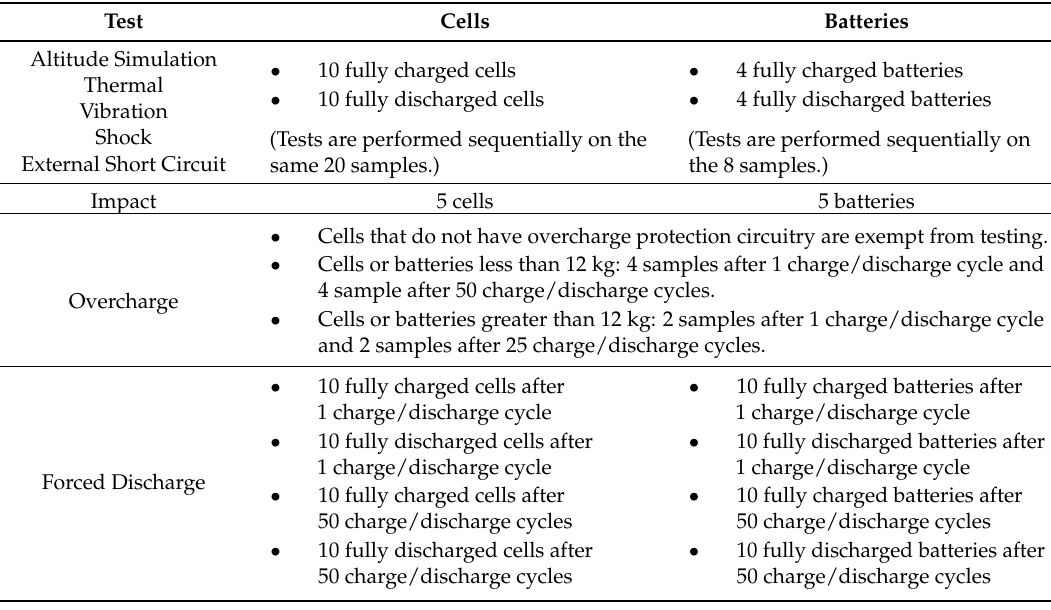
Table 1. Summary of UN regulatory tests and required sample